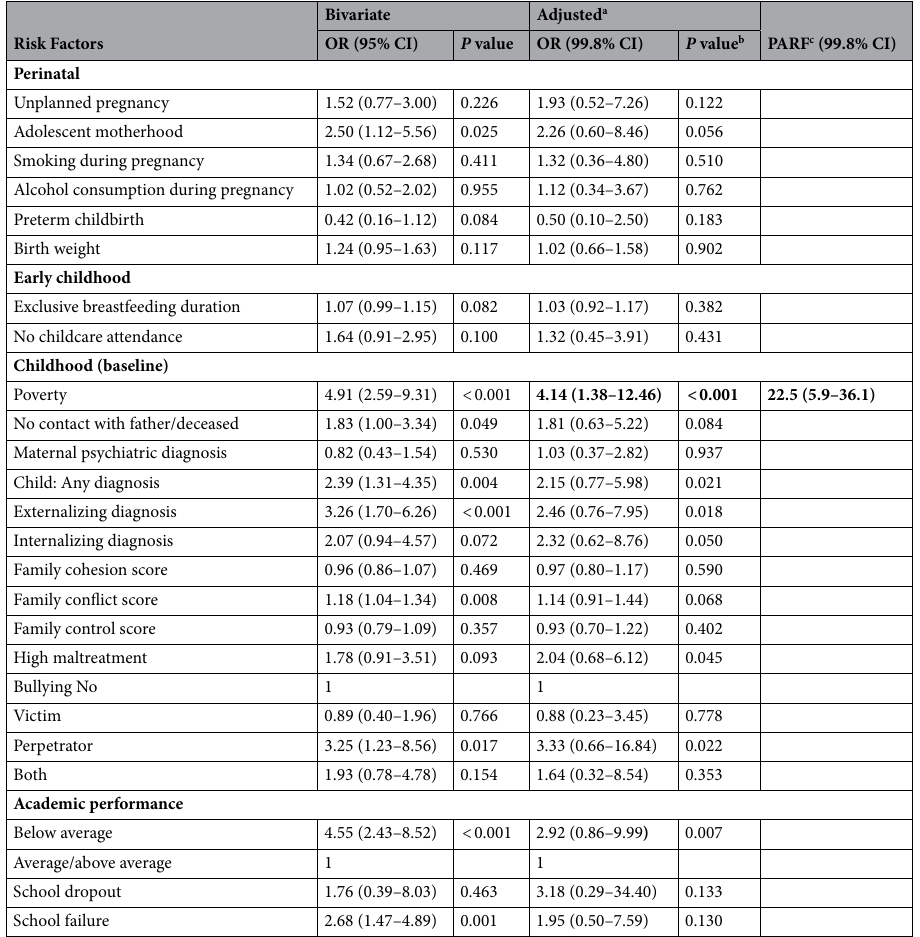
Table 2. Childhood individual and family modifiable risk factors of criminal conviction. a The association between each factor and crime was adjusted by sex, age, city, ethnicity, and intelligence quotient. b P values were considered significant with a conservative Bonferroni-corrected significance threshold of 0.05 divided by 24 tests = 0.002. c PARF = population attributable risk fraction is the proportional reduction in crime that might be eliminated if exposure to the risk factor were reduced to an alternative ideal scenario of